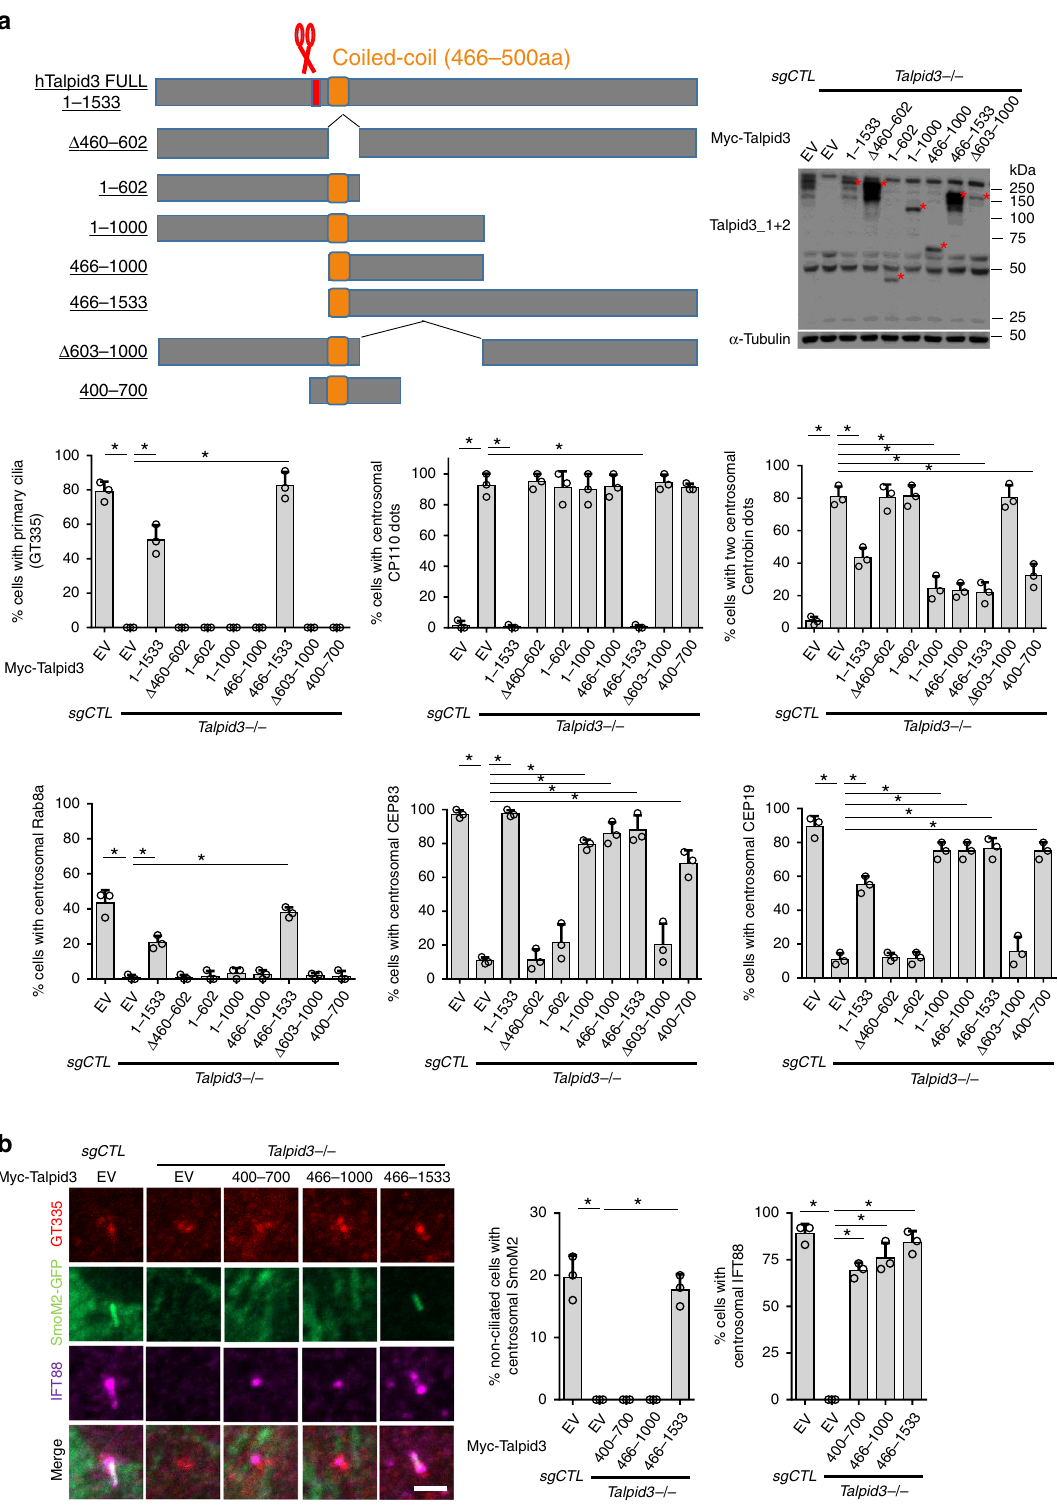
Fig. 2 Talpid3 regulates centriole maturation and vesicle docking through distinct regions. a Centrosomal and ciliary defects of Talpid3 − / − cells were rescued by infection with lentiviruses expressing different Myc-tagged Talpid3 constructs. Cells were serum-starved for 48 h and examined by IF with antibodies against indicated antibodies. Coiled-coil domain and CRISPR-targeted region of Talpid3 − / − cells are shown in orange and red (scissors), respectively. Speci fi c truncation proteins are indicated with an asterisk. The fragment spanning residues 400 – 700 is not recognized by Talpid3 antibodies and thus was detected by Myc tag, shown in Supplementary Figure 1b. b Stable Talpid3 − / − cell lines expressing Talpid3 truncations were transduced with lentiviruses expressing SmoM2-GFP. Two days after transduction, cells were serum-starved for 6 h and stained with indicated antibodies. Cumulative data from three independent experiments are shown. For each group, a minimum of 100 cells/experiment was averaged. All data are presented as mean ± SD. * p < 0.05 (unpaired t -test). Scale bar = 2 μ